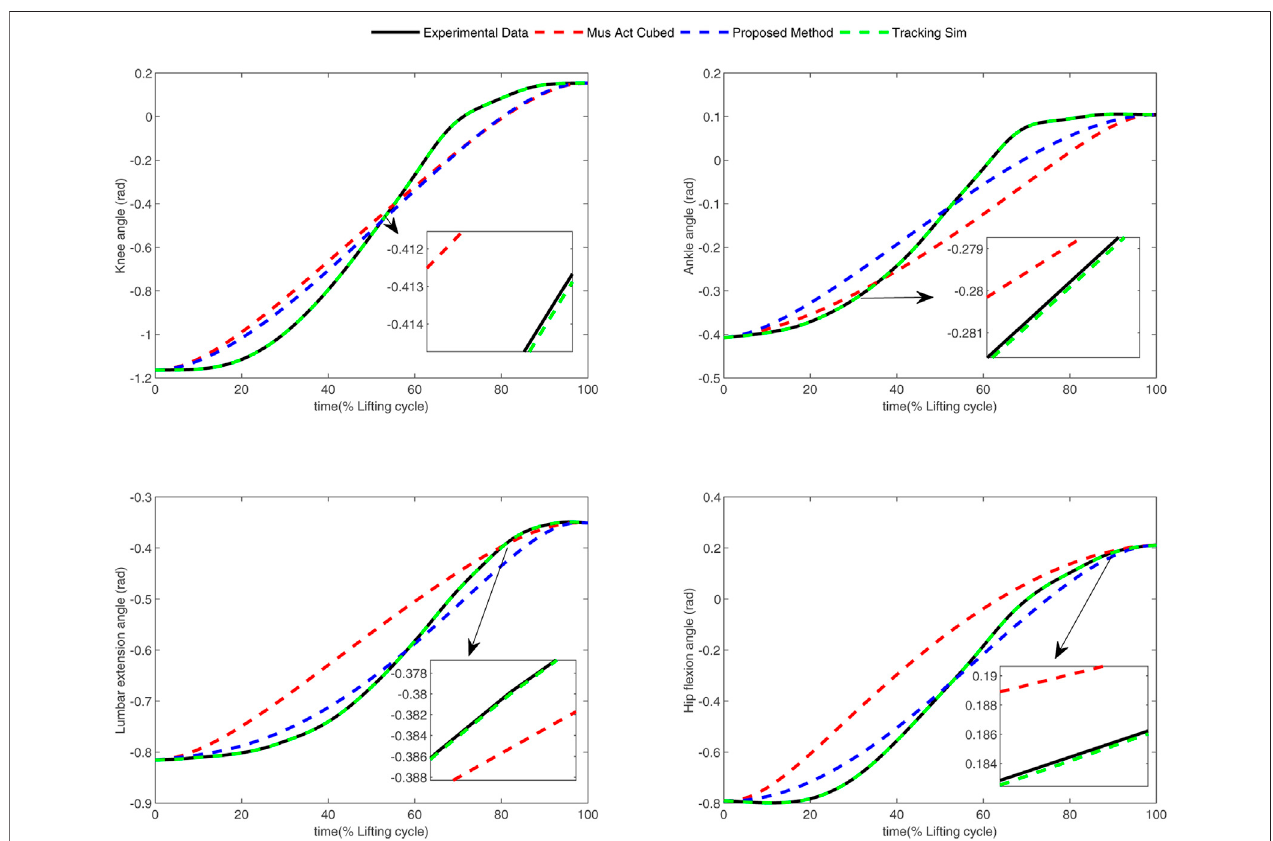
FIGURE 4 | Kinematics results of different joints obtained by different methods for subject